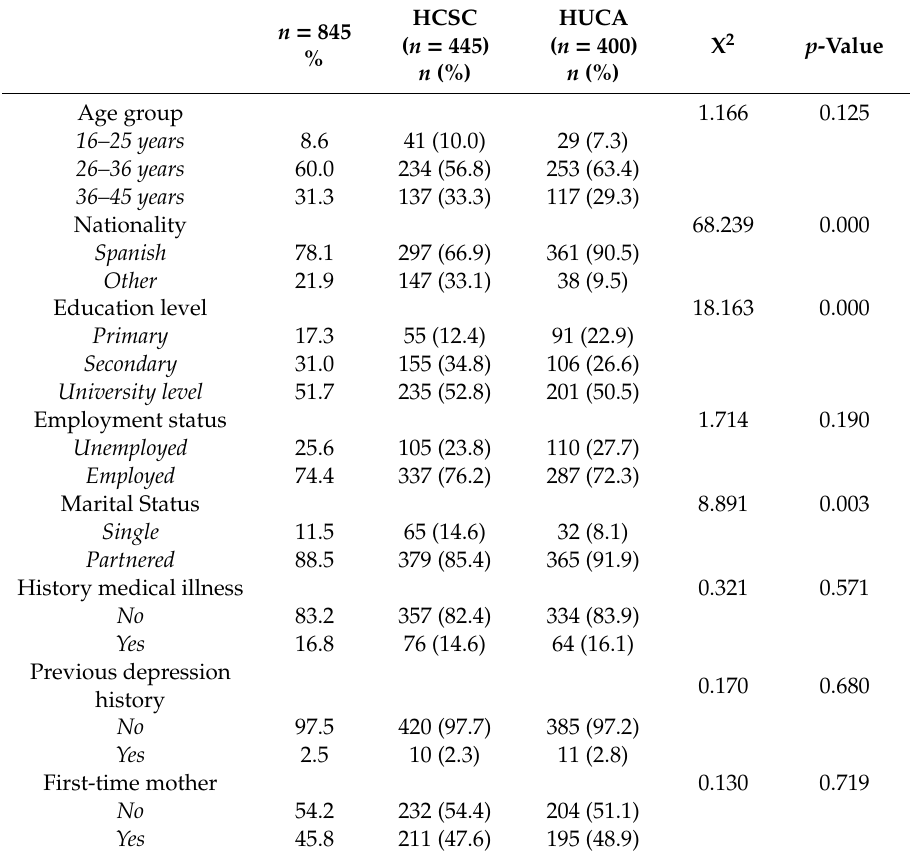
Table 1. Demographic characteristics of